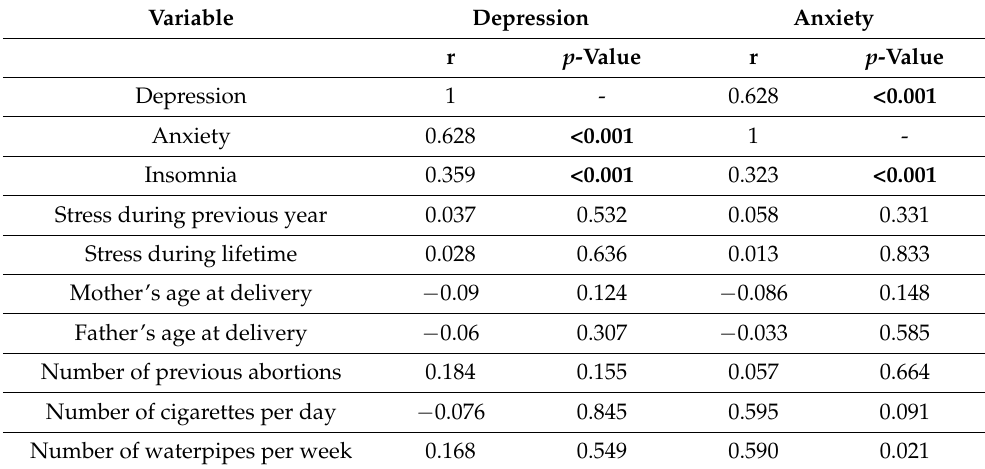
Table 5. Pearson’s correlations of continuous variables associated with postpartum depression and anxiety among the